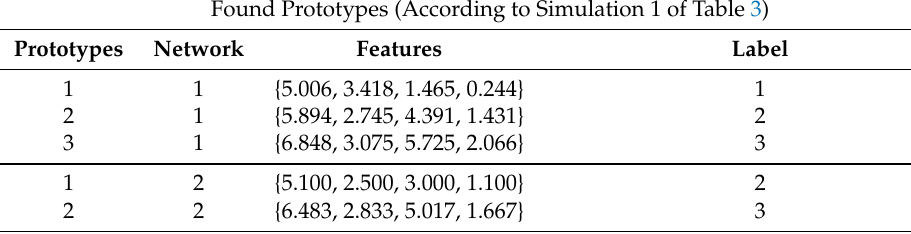
Table 4. Prototypes and strong elements according to simulation 1 of Table 3.